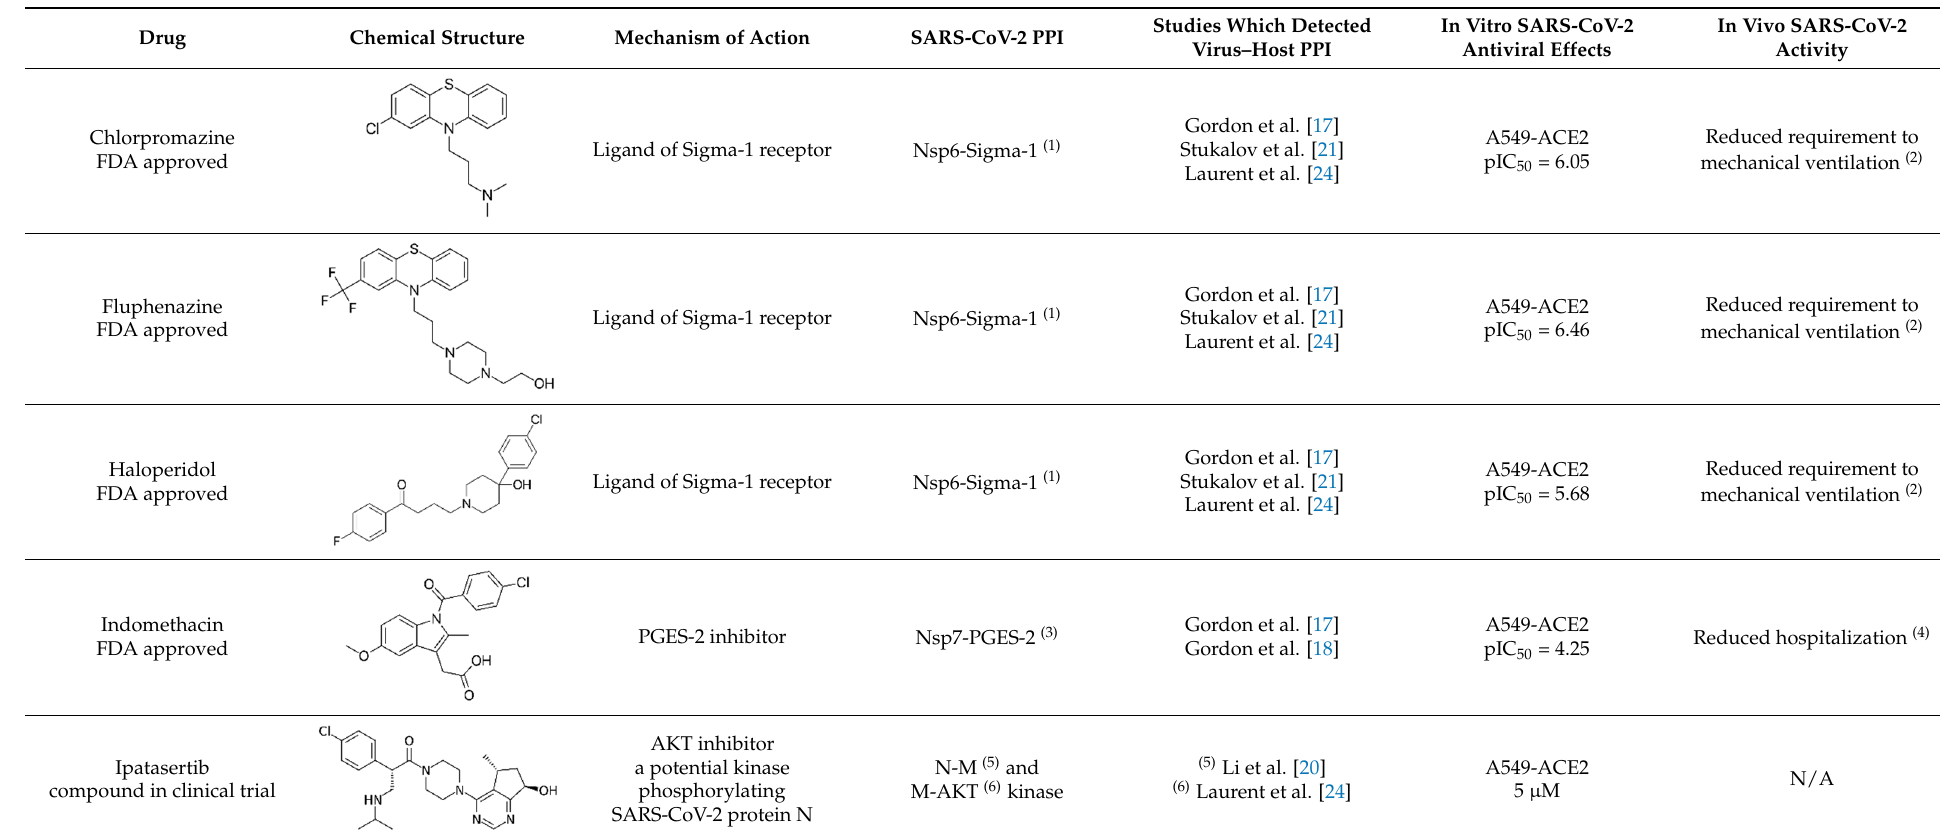
Table 5. FDA approved drugs or compound in clinical trial selected from PPI-based drug repurposing with in vitro and/or in vivo efficacy.